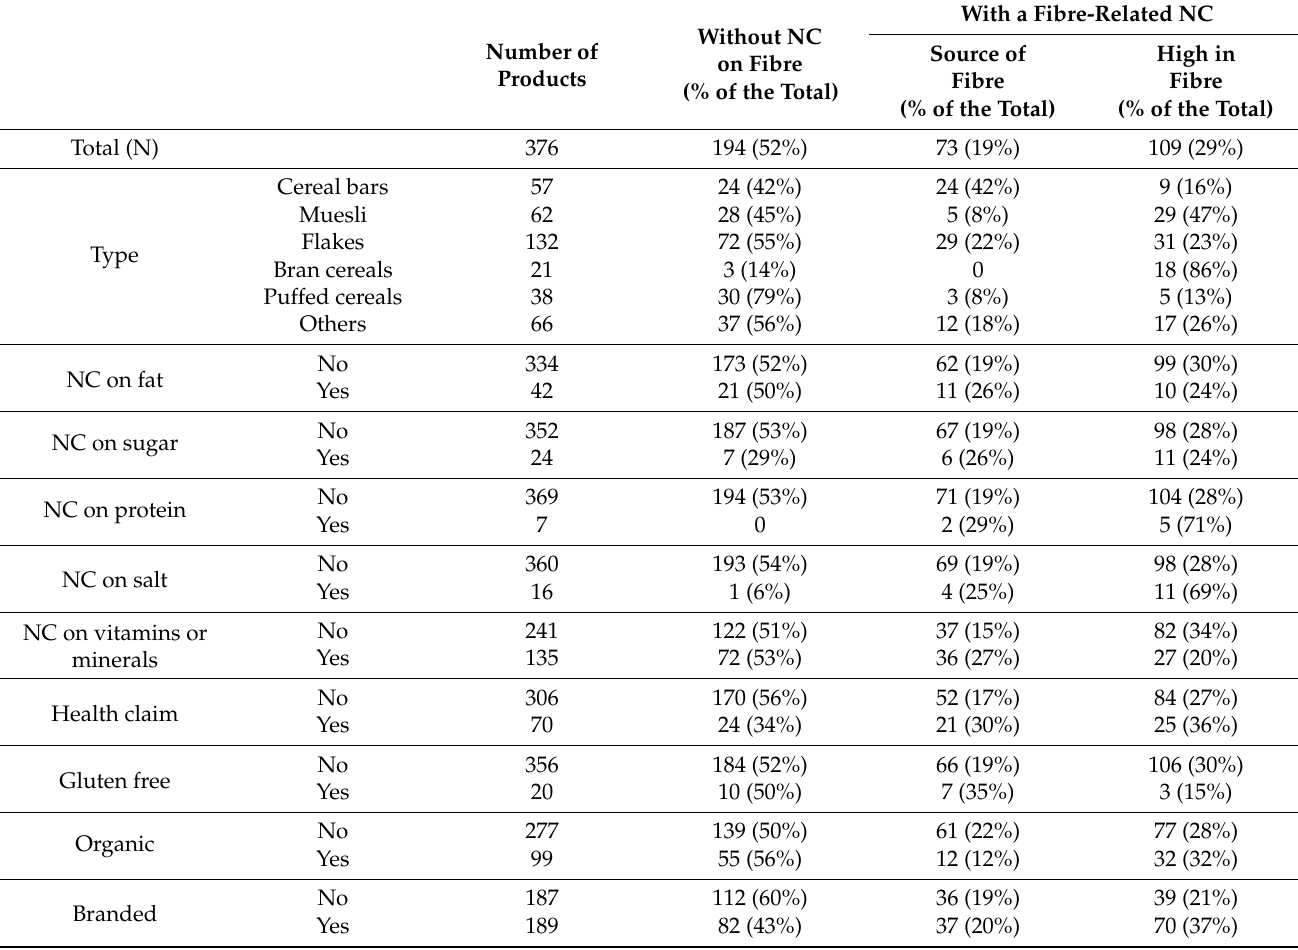
Table 1. Descriptive analysis of the breakfast cereals nutritional data available through online stores in